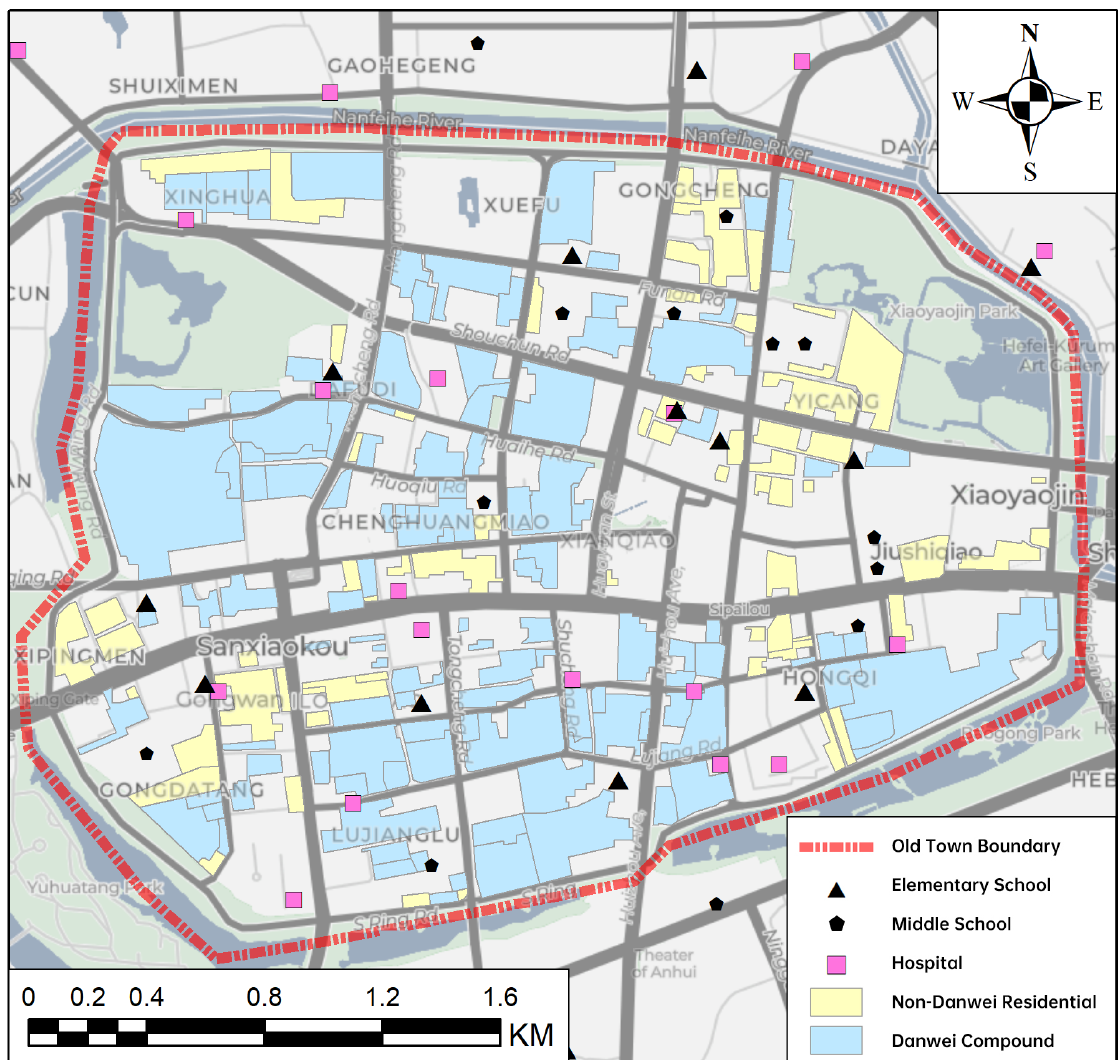
Figure 6. Distribution of Danwei compounds and non-Danwei residential in Hefei old town (Data Source: Mapbox.com,